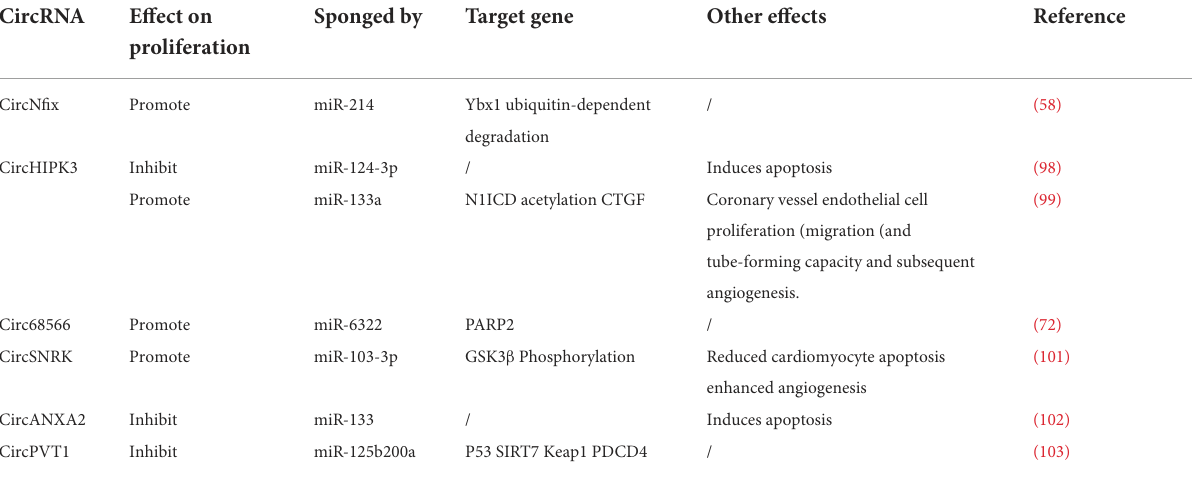
TABLE 4 A summary of the circRNAs on cardiomyocyte proliferation and the potential mechanism.